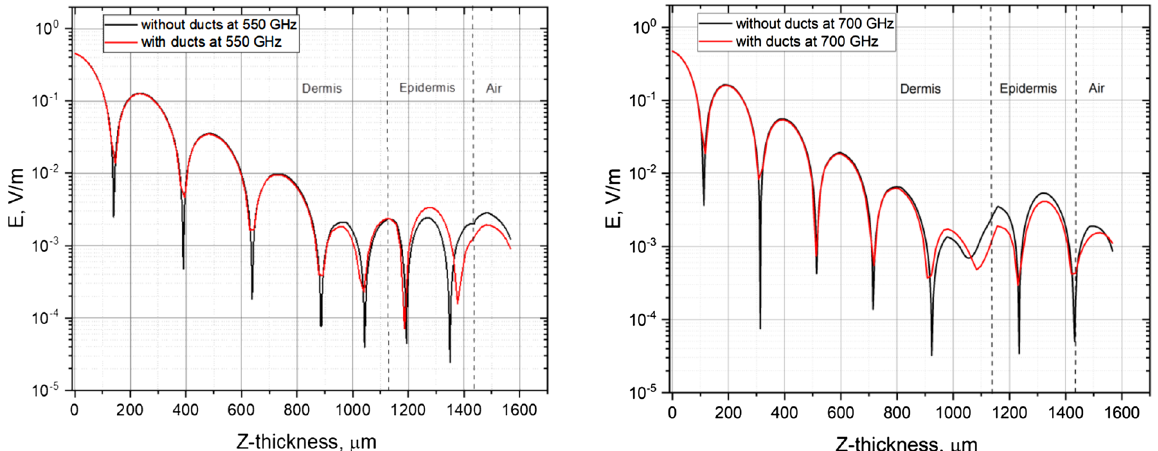
Figure 11. Log scale of the electric field as function of the skin depth. Left hand side is the simulation results for 550 GHz and the right hand side is the simulation results for 700 GHz. The continuous line is for the full model, including the sweat duct and the dashed line is the simulation results for a model without the sweat